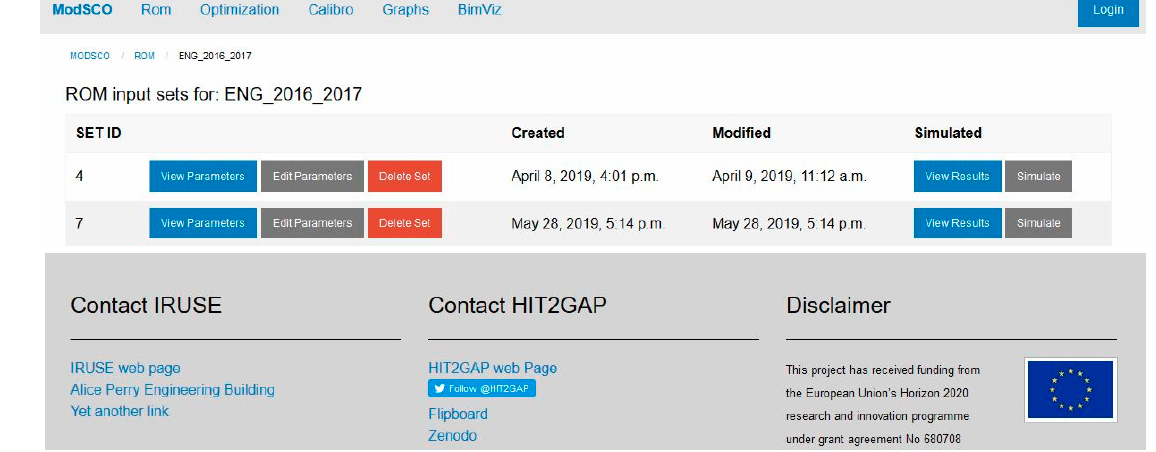
Figure 3. ModSCO models administration for a selected room.